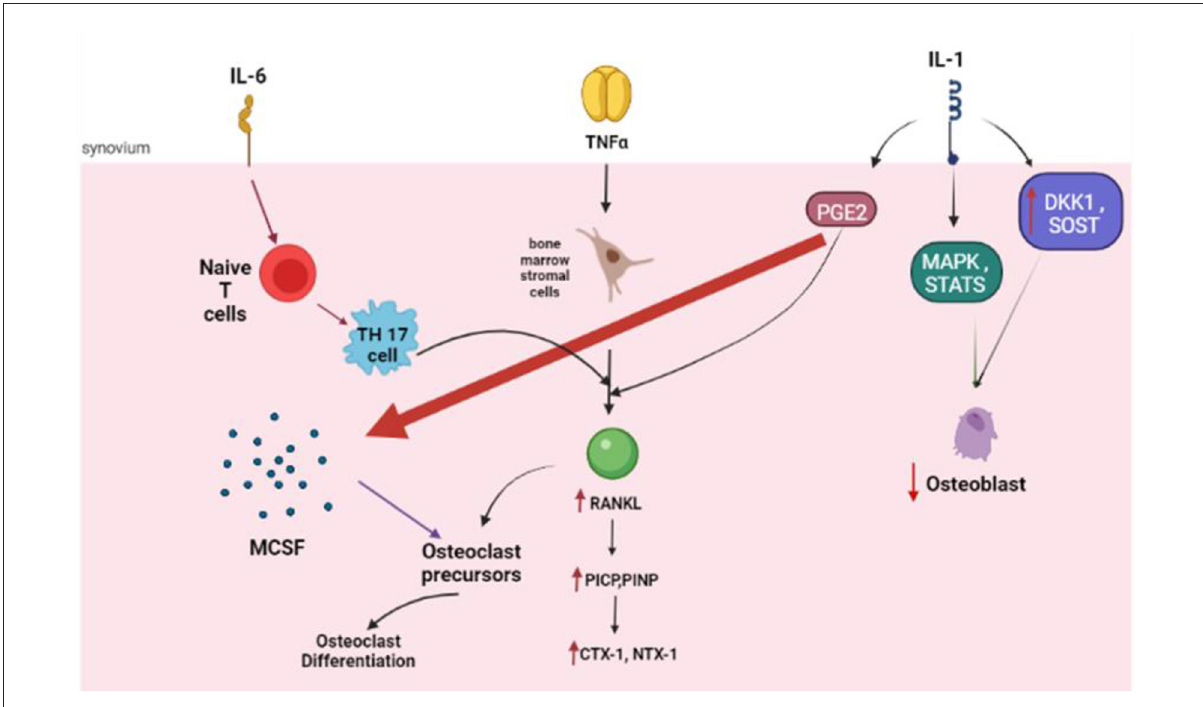
FIGURE3 The role of the key cytokines in osteoclastogenesis. IL, Interleukin; NF, Tumor Necrosis factor; RANKL, Receptor activator of nuclear factor kappa-B ligand; PICP, propeptides of type I procollagen; PINP, N-terminal propeptides of type I procollagen; CTX 1, carboxy-terminal crosslinked telopeptide of type 1 collagen; NTX 1, amino-terminal crosslinked telopeptide of type 1 collagen; PGE, prostaglandin; MAPK, mitogen-activated protein kinase; DKK1, Dickkopf WNT signaling pathway inhibitor 1; SOST,